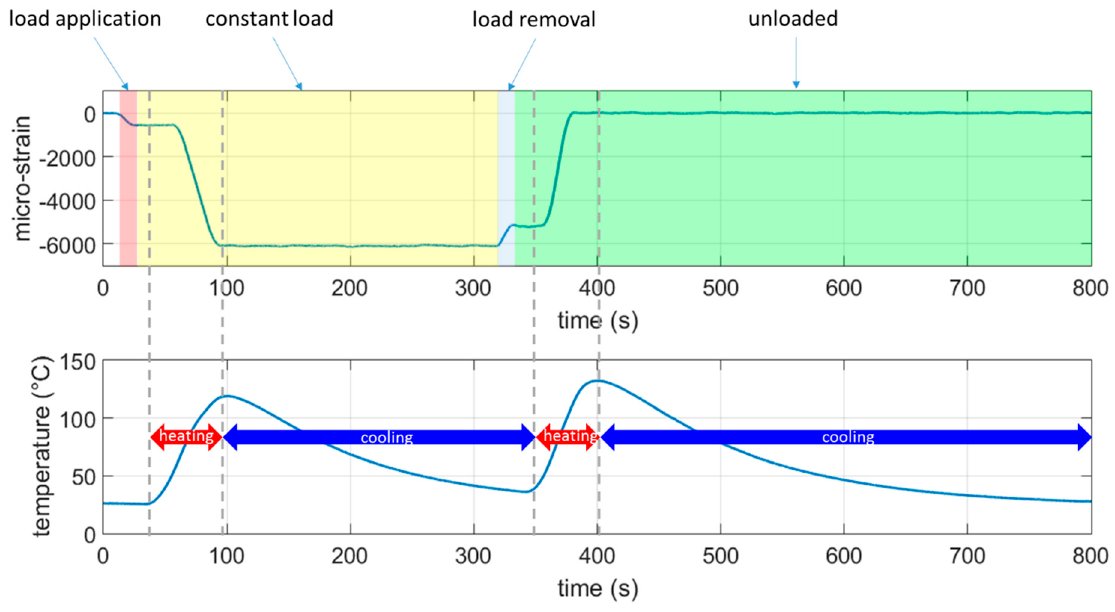
Figure 11. Strain measured close to the clamp ( top ) and temperature ( bottom ) vs. time during the entire load–unload process.